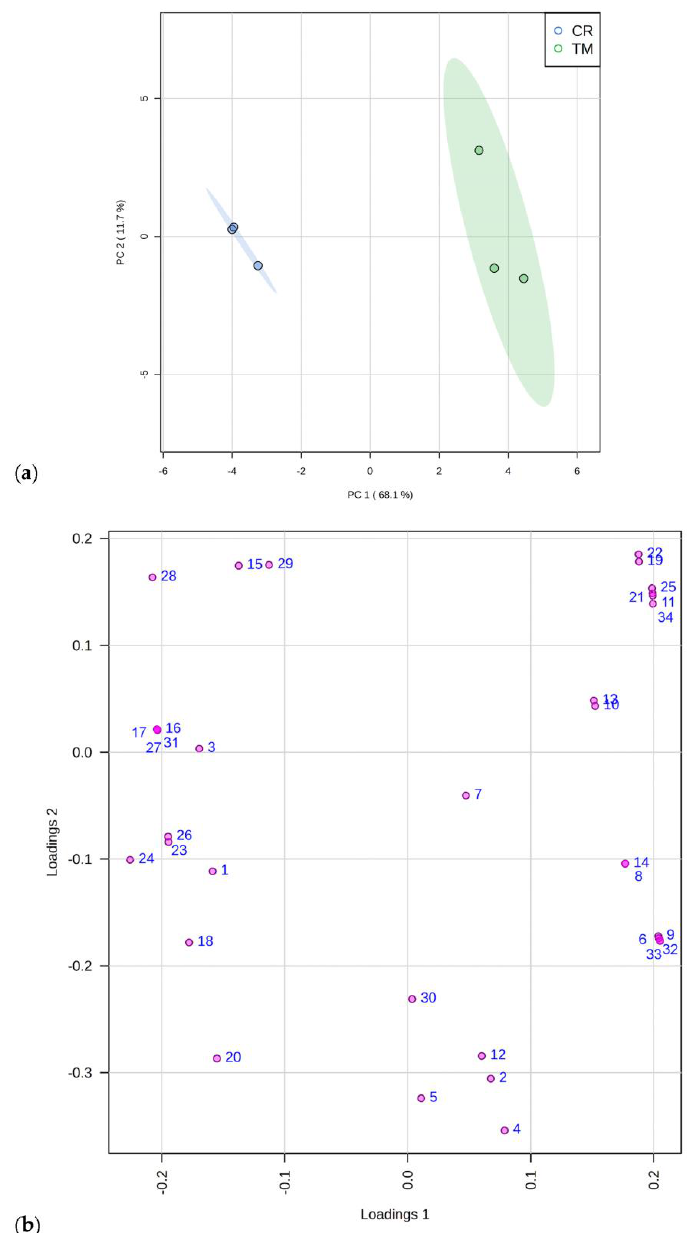
Figure 1. Principal component analysis of 34 constituents identified with GC-MS in C. ruber (L.). DC. and T. majus L. samples. ( a ) Scores plot and ( b ) loadings plot. CR, C. ruber ; TM, T. majus . The serial